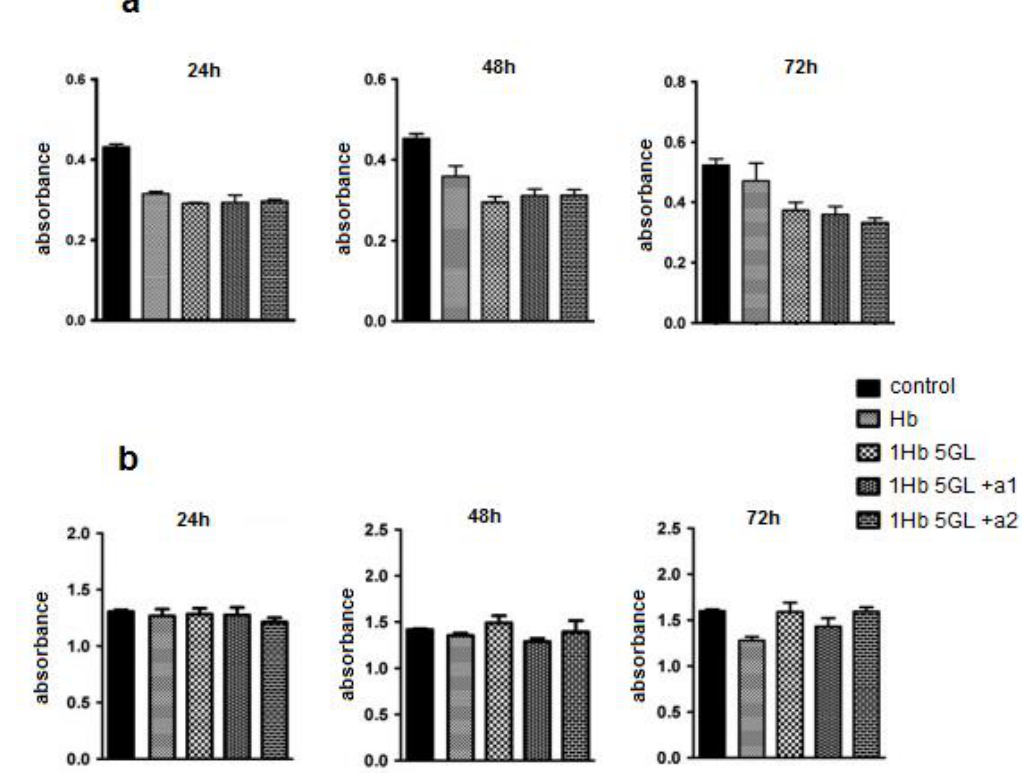
Figure 2. Effect of hemoglobin derivatization with glutaraldehyde on HUVEC cultures ( a ) and human lymphocytes ( b ) after 24, 48 and 72 h